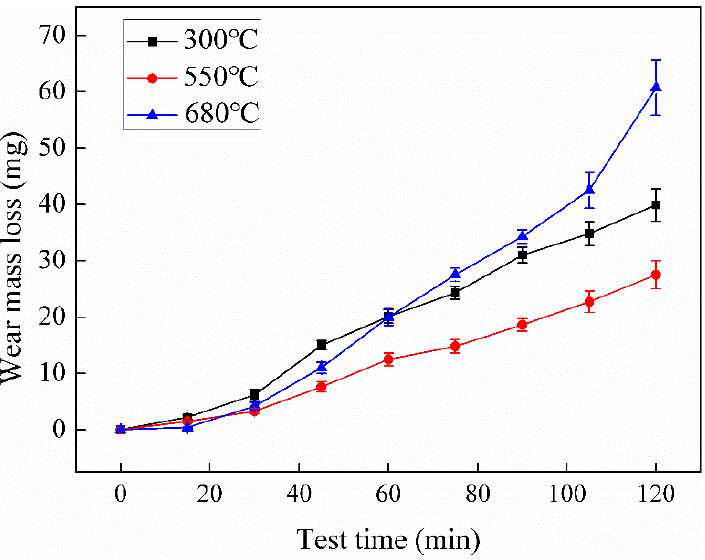
Figure 2. Weight loss as a function of wear time for the specimens tempered at different temperatures.